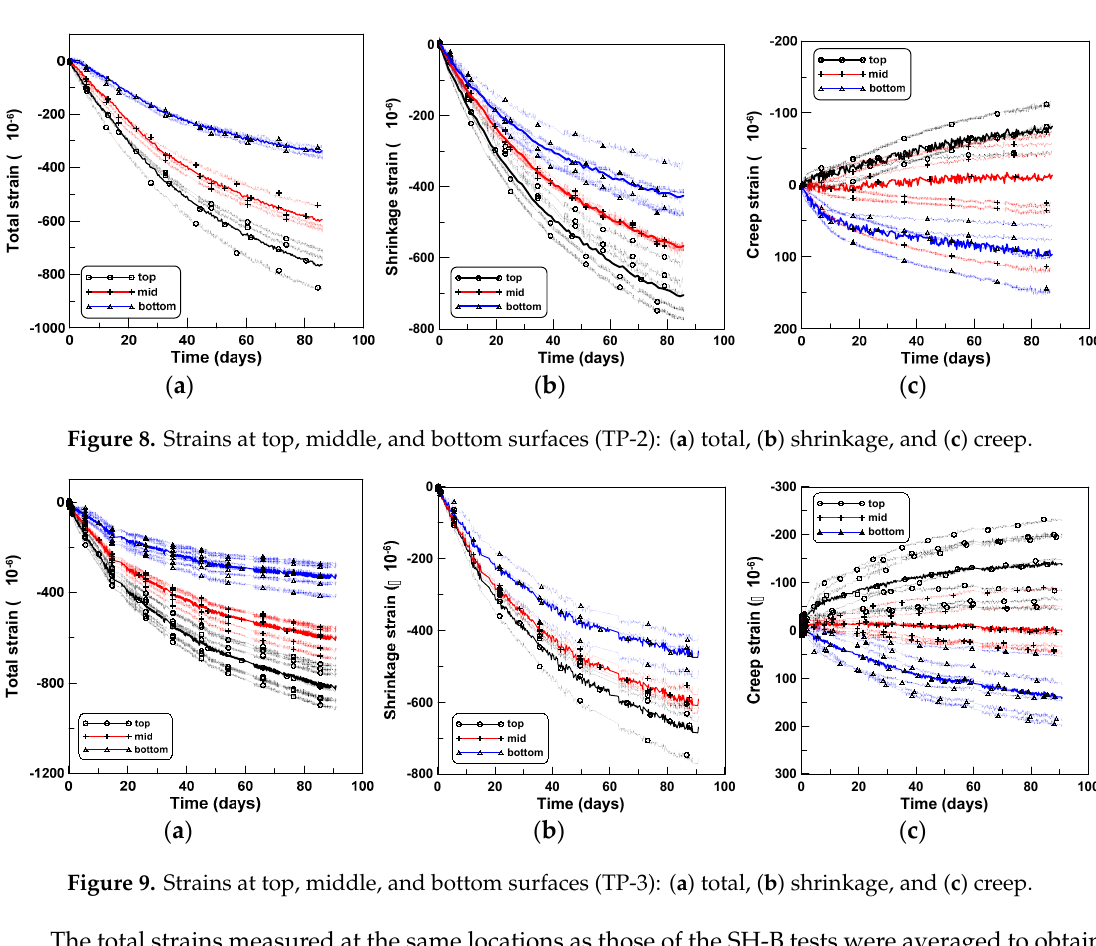
Figure 7. Strains at top, mid, and bottom surfaces (TP-1): ( a ) total, ( b ) shrinkage, and ( c ) creep.